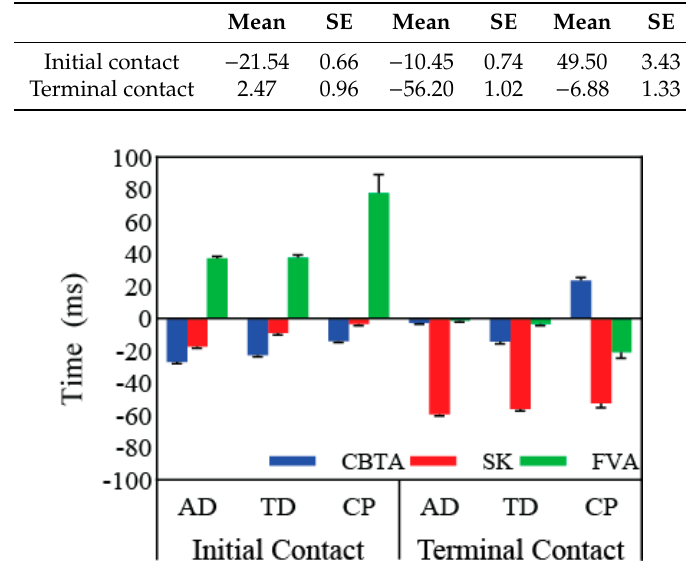
Table 2. Root mean square error (RMSE) of gait event detected timing using kinematic versus kinetic method in milliseconds (ms). CBTA: coordinate-based treadmill algorithm; SK: shank angular